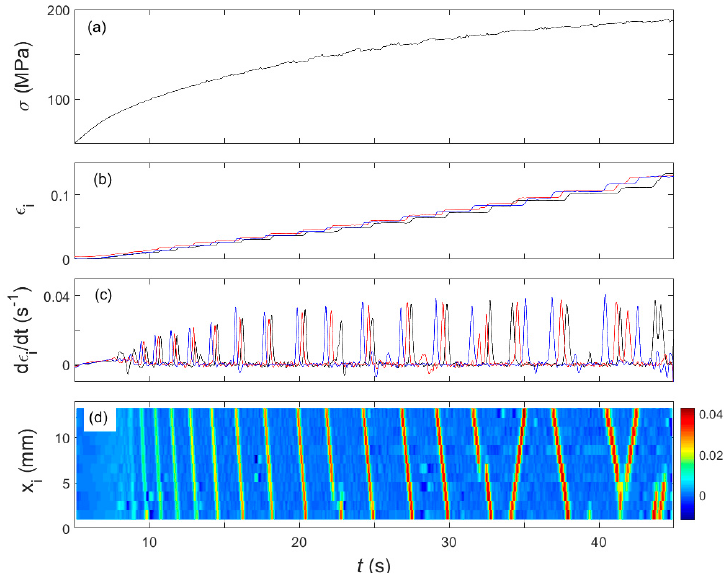
Figure 1. Example of synchronization of stress and strain responses. ( a ) Portion of a stress-time curve σ ( t ) corresponding to serrated deformation. ( b ) Evolution of strains ε i ( t ) measured by three local extensometers selected near the opposite ends and in the middle of the field of vision of the charge-coupled device (CCD) camera. ( c ) The corresponding local strain rates ε i . ( d ) The strain-rate map constructed using 14 local extensometers remaining within the field of vision during test. x i ( t ) gives the position of the center of the i th extensometer. The color bars quantify the strain-rate scale (s − 1 ). The peak i value within bright lines exceeds ε a by a factor of about 7 (cf. [9,47,48]).